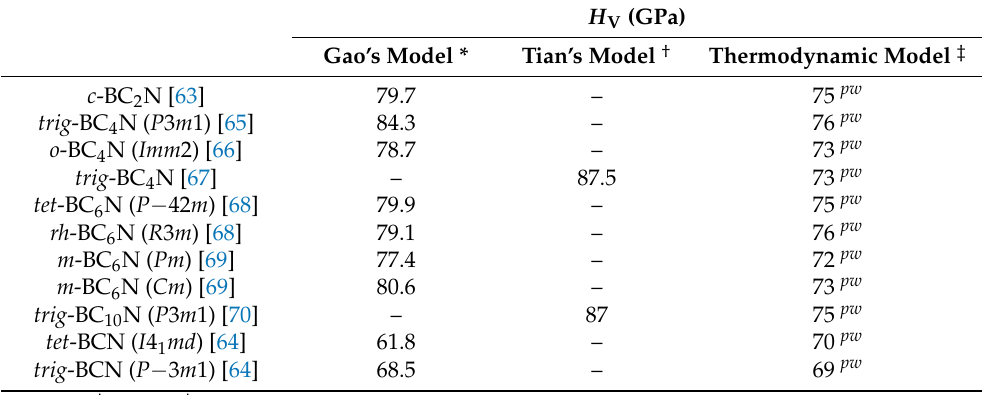
Table 3. Vickers hardness of hypothetical ternary B–C–N phases calculated using different